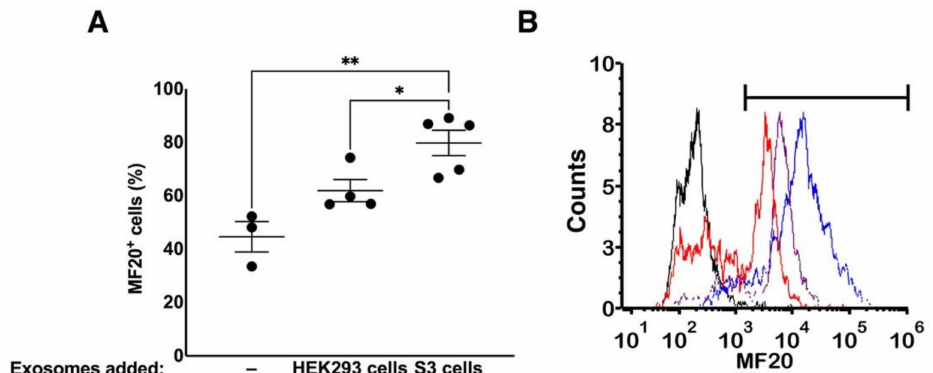
Figure 7. Effect of exosomes on differentiating hPSCs. ( A ) Exosomes from S3 B12-3 cells (50 µ g) were added to S2 cultured B12-3 cells (confluent wells of a 12-well plate) inducing an increase in MF20 + cells at day 8 as mean ± SEM; * p = 0.0457, ** p = 0.016. ( B ) A representative flow cytometry run from the experiments in ( A ) is shown. Curves: Black-Isotype control; Red-no added exosomes; Purple-HEK293 cell exosomes added; Blue-S3 exosomes